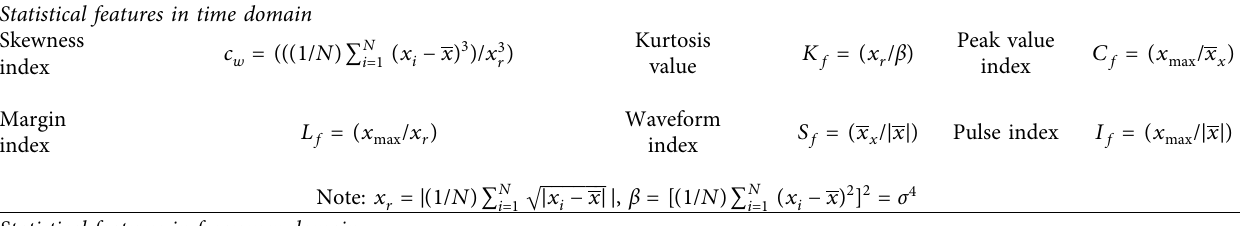
Table 3: The formula of the partial extracted